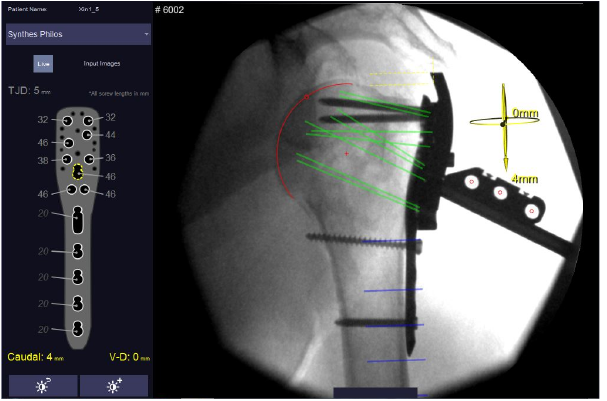
Figure 8. Intraoperative X ‐ ray of one case with tilted screws (PHILOS A ‐ level) as apparent by non ‐ alignment with the calculated screw trajectories (green lines).